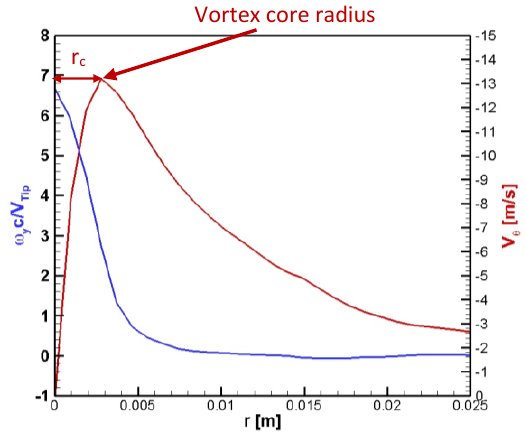
Figure 4. Tip vortex main characteristics. Tangential velocity (red curve) and normalised out-of-plane vorticity (blue curve) vs. vortex radius. The vortex core radius is detected by the maximum tangential velocity (V θ